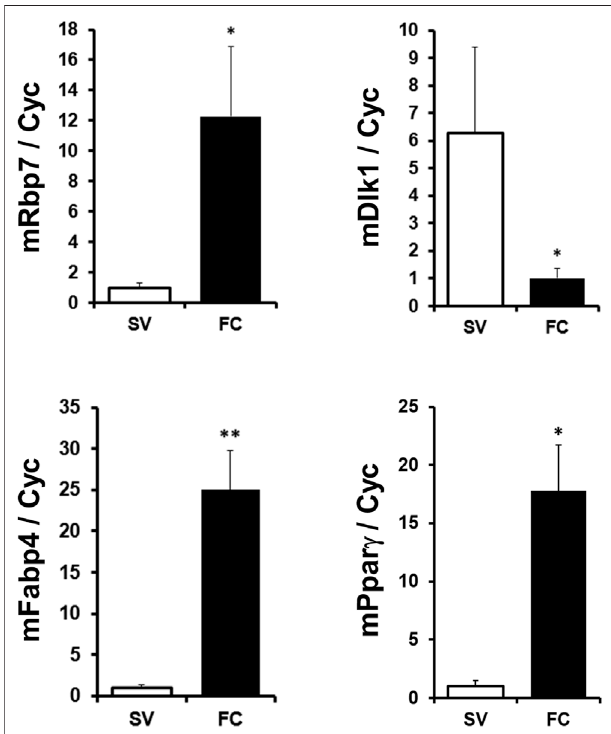
FIGURE 2 | RBP7 expression in stromal vascular cell and fat cell fractions. Subcutaneous adipose tissues were separated to the fractionation of stromal-vascular cell (SV) and fat cell (FC), and analyzed. Fabp4 and Ppar γ genes were used as adipocyte markers. DLK1 was used as a preadipocyte marker. t -test was used for statistical analysis by the Graphpad PRISM6.02program.Thebarsindicatemeans±S.E.M.* p < 0.05,** p < 0.01.